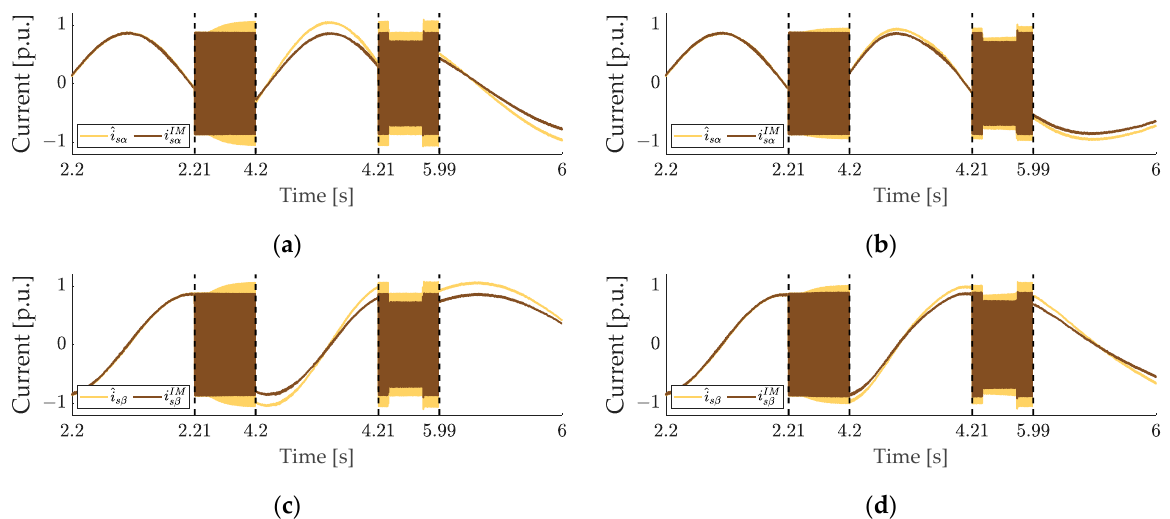
Figure 12. Estimated and measured stator current in α axis ( a , b ) and β axis ( c , d ) during CS fault in phase A for: k 0 = 1 ( G = 0) ( a , c ) and v 3 operation mode for k 0 = 0.6 ( b , d ); r rIM = var, r sIM = var.